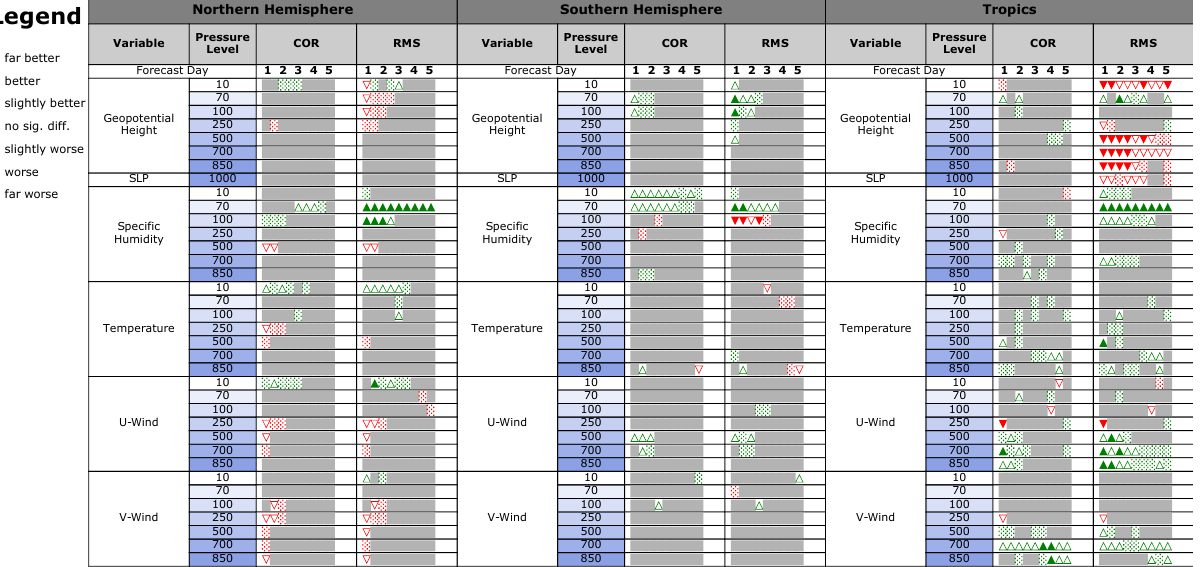
Figure 14. Same as in Figure 12, but for GK2AHE (experiment) and CNTL (control) against ERA-5 analysis. This shows the effect of replacing H-8 AMVs with GK2A AMVs in the operational GEOS.